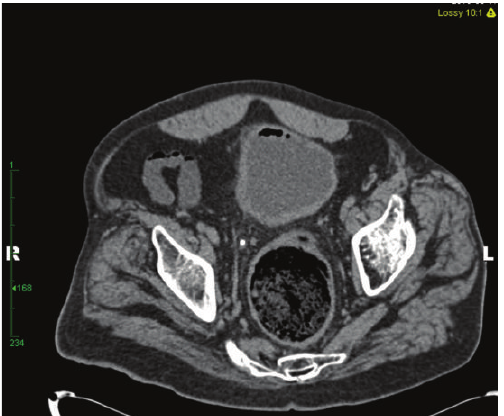
Figure 4: CT pelvis illustrates the presence of gas in the lumen of the bladder. There is no presence of gas in the wall of the bladder to suggest emphysematous